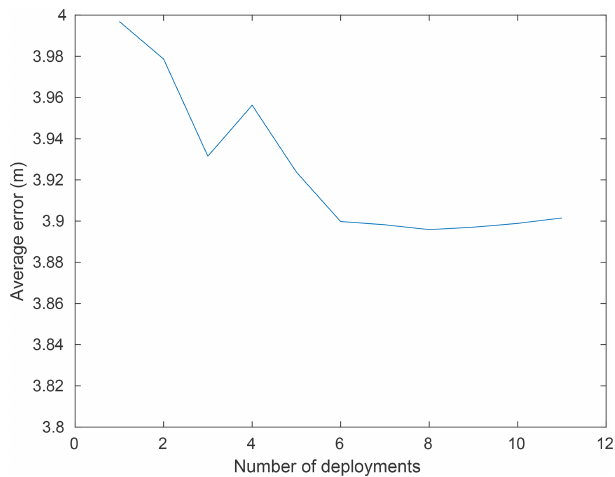
Figure 6. Convergence of the average error for the supraglacial channel reconstruction with respect to the number of deployments. Each deployment results in a separate independent dataset that is used to create a new distinct water flow path reconstruction. The reconstructed water flow paths are aligned and